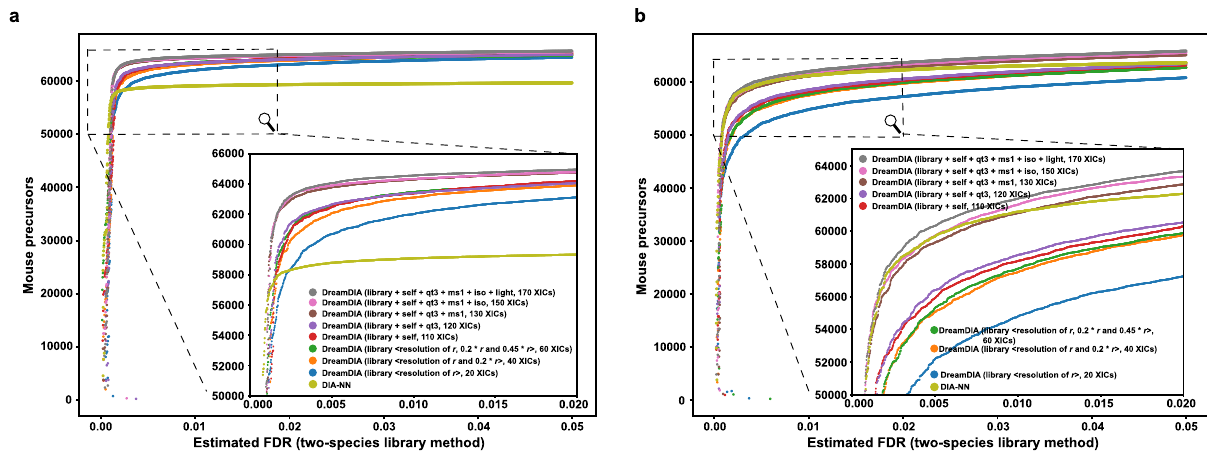
Fig. 4 Optimization of the representative spectral matrix compositions in DreamDIA. The deep representation models trained on the RSMs with eight different compositions as well as DIA-NN were tested on the S1-1 run of mouse cerebellum dataset using a DIA-Umpire library and b DDA master sample library. Two-species FDR estimation method was used as in Fig. 2. The numbers of mouse precursors identi fi ed at different FDRs were plotted. r , the basic resolution that can be speci fi ed by users according to the acquisition